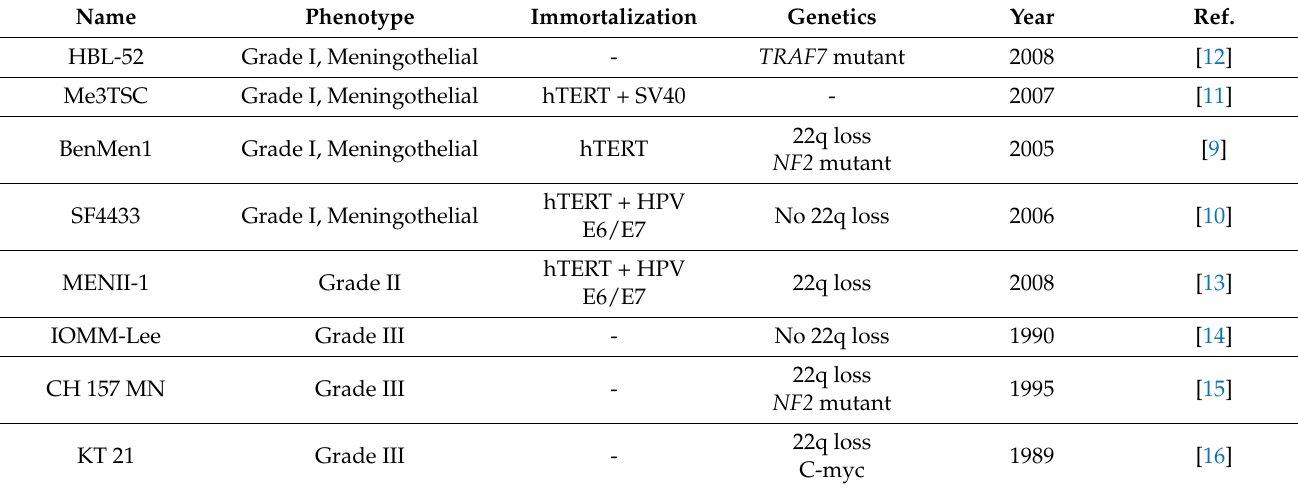
Table 1. Summary of principal meningioma cell